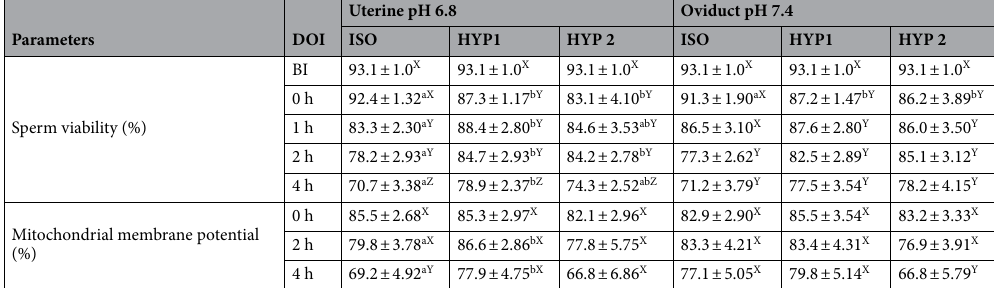
Table 1. Influence of osmolality and pH on viability and mitochondrial membrane potential in bovine sperm incubated in vitro (Mean ± SEM). DOI: Duration of incubation; ISO: 290 mOsm/kg; HYP1: 355 mOsm/kg; HYP2: 420 mOsm/kg; BI: Before incubation. Values with superscript bearing a,b within a row for a particular time point and pH differ significantly ( p < 0.05). Values with superscripts bearing X,Y,Z within a column for a particular parameter differ indicating a significant effect of time ( p < 0.05). The interaction effect of osmolality by incubation time was significant ( p < 0.05) for sperm viability and mitochondrial membrane potential.